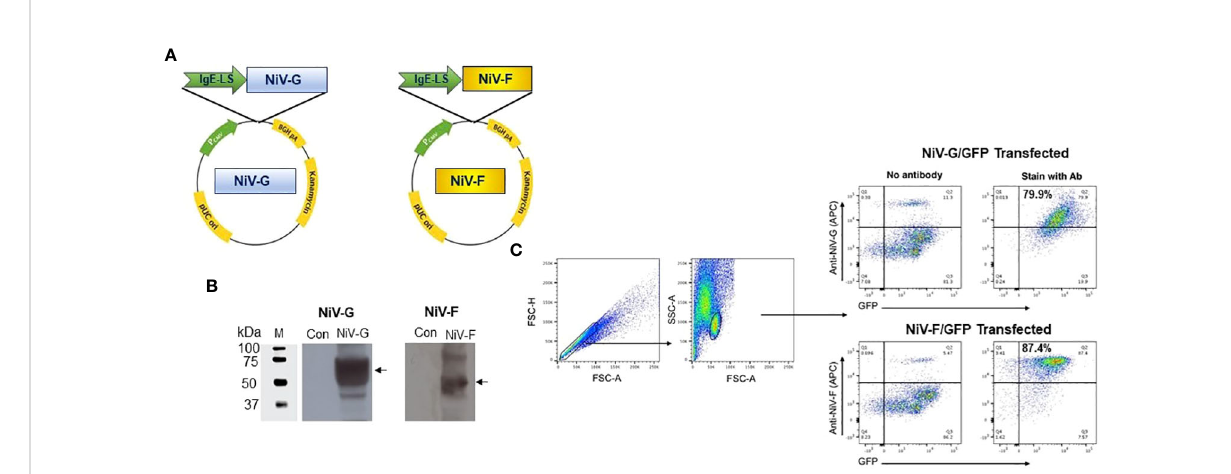
FIGURE 1 Generation and characterization of NiV-F and NiV-G speci fi c vaccine. (A) Schematic diagram of NiV-vaccine encoding either synthetic consensus NiV-F or NiV-G antigens. (B) Western analyses of cell lysates from cells transfected with pNiV-G and pNiV-F vaccines probed with antibodies speci fi c to each transfected cell lysates. The lanes were loaded with 20 m g of total protein from the vaccine-transfected cell lysates. Negative control was established with pVax1 transfected cells (Con). (C) Flow cytometric determination of transgene expression. HEK293T cells were transfected with pNiV-G-GFP or pNiV-F-GFP and then analyzed by fl ow cytometry two days post-transfection cells to detect the surface expression of NiV-G and NiV-F protein using an antibody speci fi c to each vaccine. Representative plots for fl ow cytometry gating strategy were shown for forward and side scatter and discrimination of doublets and percentage of unstained cells (negative control/GFP only) and cells without speci fi c antibodies are added. In this plot, Q2 quadrant demonstrates cells that express target proteins (NiV-G-GFP or NiV-F-GFP) and show GFP fl uorescence. The percentage of positive cells is indicated in Q2